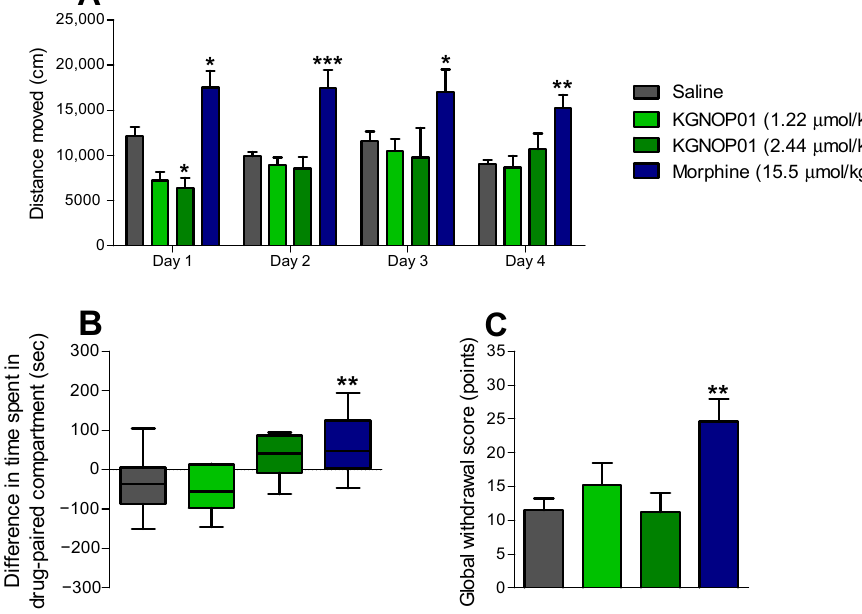
Figure 4. Behavioral responses induced by KGNOP1 and morphine after chronic s.c. administration to mice. ( A ) Spontaneous locomotor activity in mice treated with saline (control), KGNOP1, or morphine as distance traveled during 30 min after drug daily administration for 4 days. ( B ) Rewarding effects in mice treated with saline (control), KGNOP1, or morphine in the CPP test after drug conditioning for 4 days. ( C ) Physical dependence as naloxone-induced withdrawal syndrome in mice treated daily for 5 days with saline (control), KGNOP1, or morphine. Withdrawal was precipitated two hours after last drug administration using naloxone (1 mg/kg, s.c.) and signs of withdrawal were measured over 15 min immediately after naloxone, and a global withdrawal score was calculated. See also Figure S1. Data are presented as the mean ± SEM (n = 8 mice per group). ** p < 0.05, ** p < 0.01, and *** p < 0.001 vs. saline group, two-way ANOVA followed by Bonferroni’s post hoc test ( A ); * p < 0.05 and ** p < 0.01 vs. saline group, one-way ANOVA followed by Dunnett’s post hoc test ( B , C